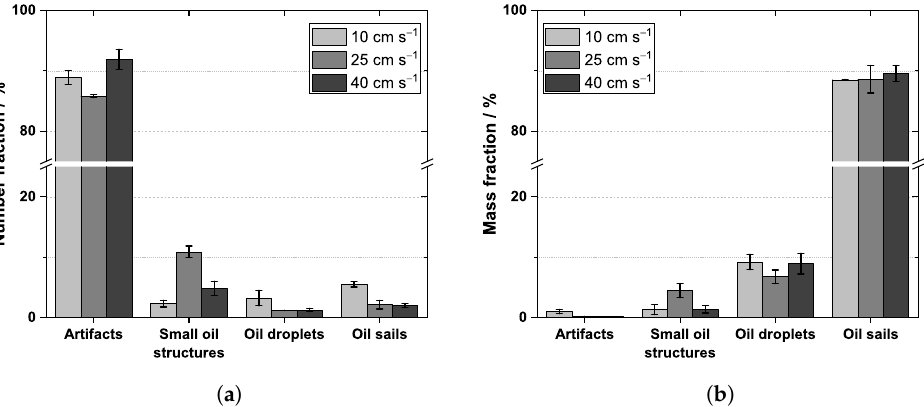
Figure 7. ( a ) Number and ( b ) mass fractions of the identified oil objects at different filtration velocities. Error bars indicate the standard